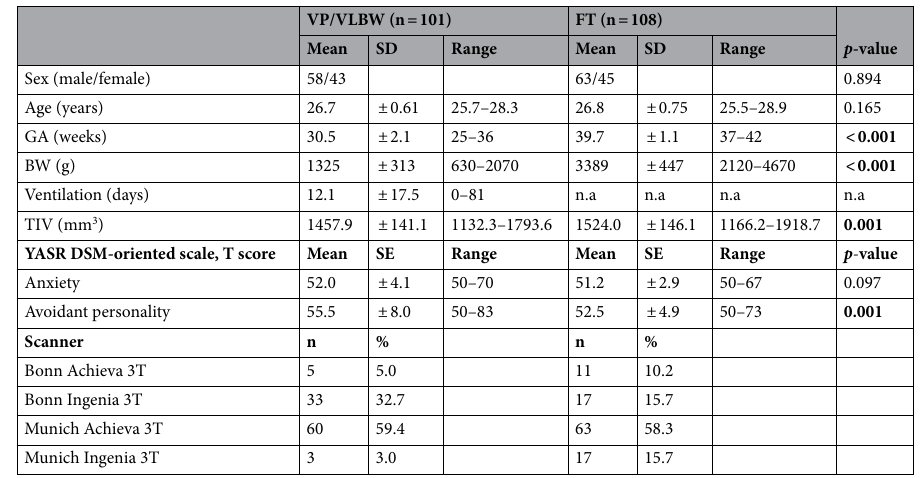
Table 1. Demographical, clinical and cognitive data. Statistical comparisons: sex with χ 2 statistics; age, GA, BW, TIV and YASR with two sample t-tests. Bold letters indicate statistical significance defined as p < 0.05. BW, birth weight; DSM, Diagnostic and Statistical Manual of Mental Disorders; FT, full-term; GA, gestational age; SD, standard deviation; SE, standard error; VP/VLBW, very preterm and/or very low birthweight, YASR, Young Adult Self